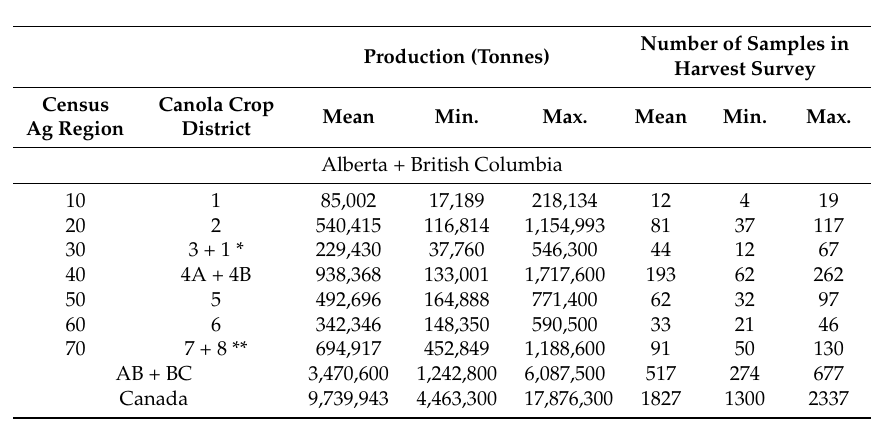
Table 2. Cont. Production (Tonnes)